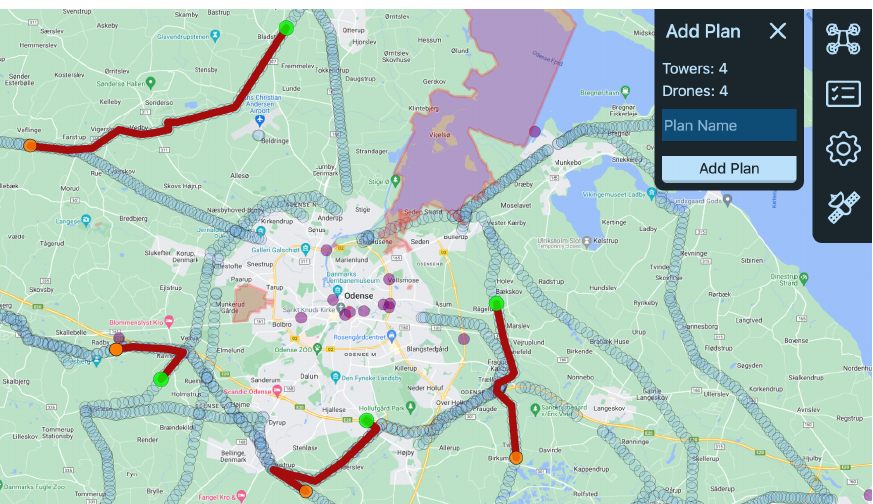
Figure 7. Example of a solution for the path planning problem with four drones reaching four inspection targets. The solution paths are shown in red. Drones are shown as orange circles, inspection targets as blue (power towers) and purple (bridges), and selected inspection targets are shown as green